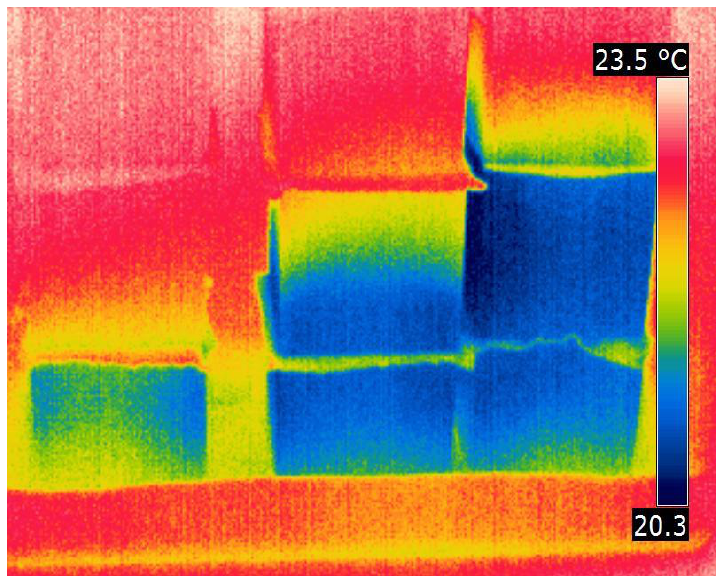
Figure A5. Thermographic report dated October 26, 2018, for Carparo (C.), Lecce stone (L.S.), and Tuff (T.).